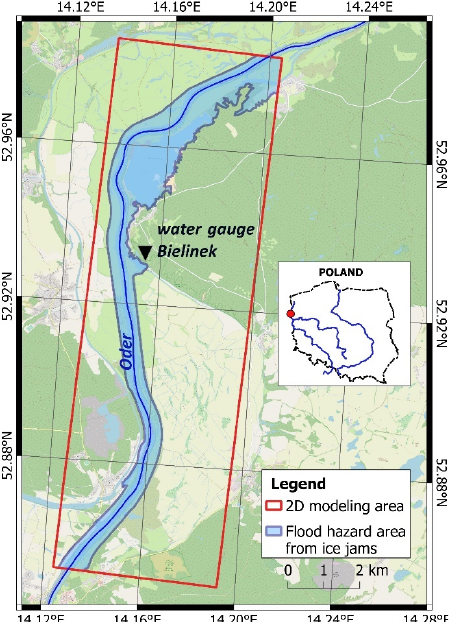
Figure 6. Flooded area along the Oder River at Bielinek, Poland (base map from OpenStreetMap https://www.openstreetmap.org/#map=7/52.012/16.414 accessed on 14 December 2022).